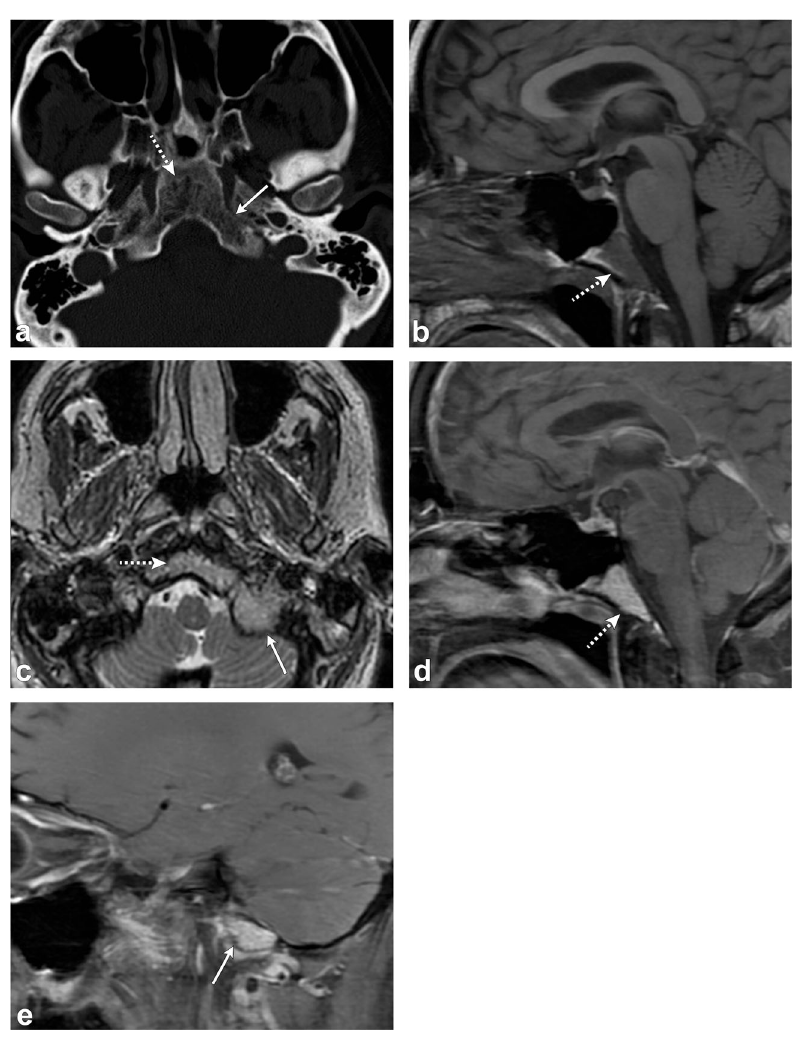
Fig. 7 Osseous venous vascular malformation. Axial head CT ( a ) shows osteolytic changes (trabecular appearance) of the clivus ( dashed arrow ) extending into the leftoccipitalcondyle ( thin arrow ). Sagittal T1-weighted ( b ), axial T2-weighted ( c ) and post- contrast sagittal T1-weighted images ( d , e ) show abnormal signal in the clivus ( dashed arrows ) and left occipital condyle ( thin arrow ) with